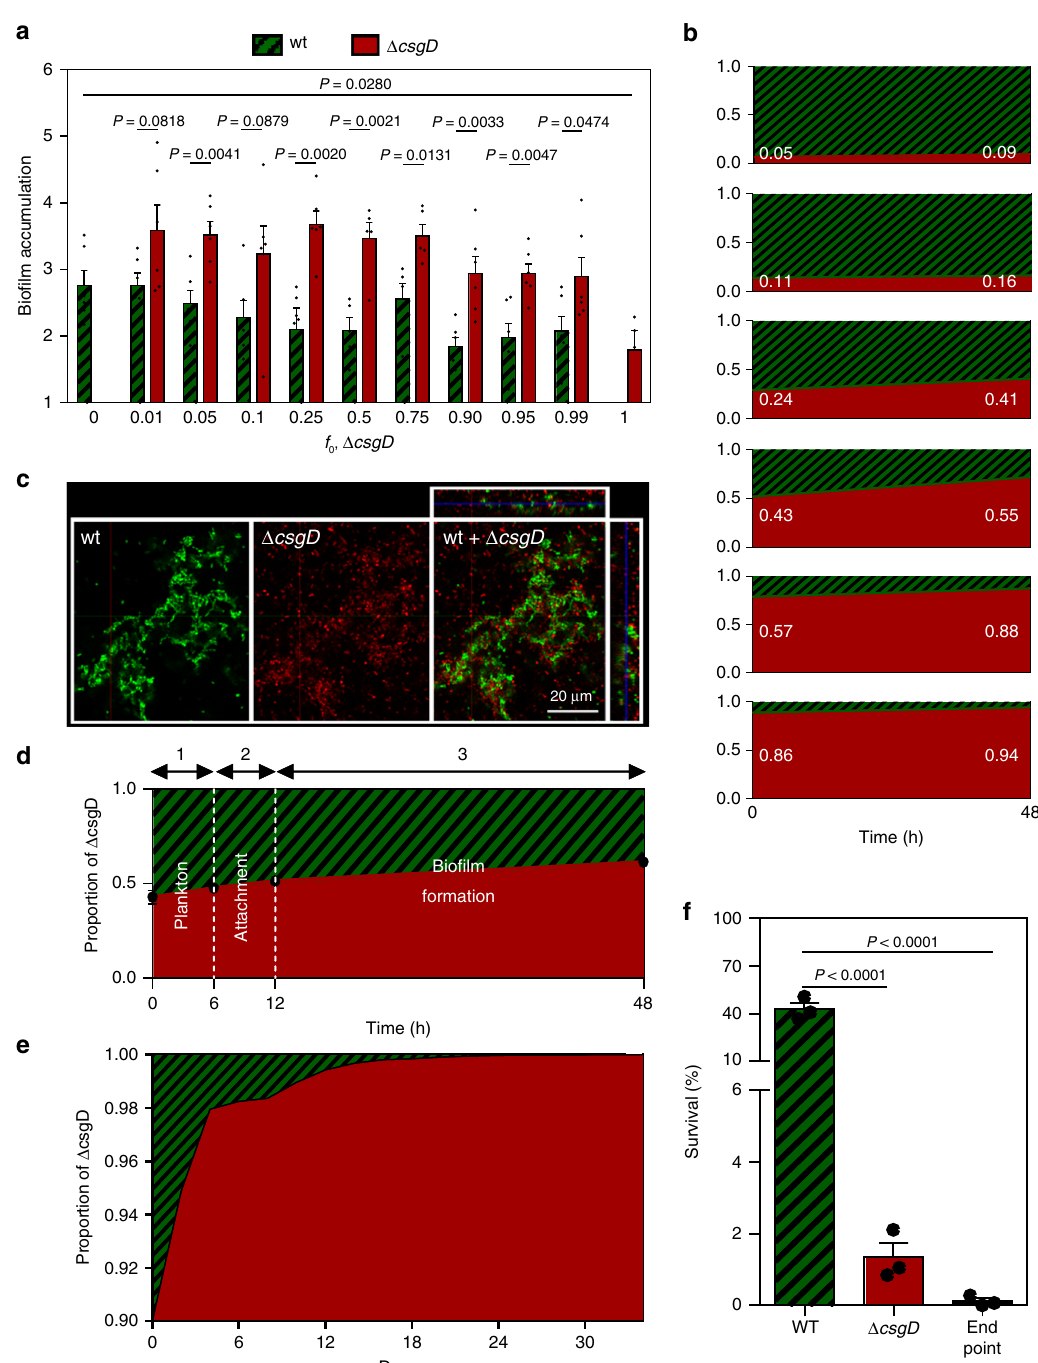
Fig. 2 Salmonella bio fi lm EPS is exploitable. Wild-type strain ATCC14028 (EPS producer) is indicated in (shaded) green; the isogenic Δ csgD mutant (EPS non-producer) is indicated in red. a Normalised bio fi lm accumulation of each strain during short-term competition, calculated as log inoculation fraction of Δ csgD . b Proportion of strains during short-term competition. c Confocal image of association between EPS producer and non- producer in the bio fi lm after 48 h ( f 0, Δ csgD = 0.9); left: split images, right: combined image. d Proportion of strains at different stages of growth during competition in petridishes, 1: plankton before attachment; 2: bio fi lm during attachment; 3: bio fi lm after attachment. To exclude interference from attaching cells when studying competition during growth in the bio fi lm, the planktonic phase above the bio fi lm was replaced by sterile nutrients at the 12 h time point. e Proportion of strains during long-term competition. f Survival of endpoint populations of long-term competition after treatment with H 2 O 2 (0.25%) in comparison with wild-type and Δ csgD mutant. For competition experiments a , b , d , e and microscopy c , wild type and Δ csgD mutant were fl uorescently labelled in green and red, respectively. A similar outcome a , b , and c was obtained when colors were reversed and competition was neutral when strains that only differ in the fl uorescent protein marker were competed against each other (Supplementary Fig. 2). Bars represent mean, dots represent measurements for biological replicates and error bars show s.e.m. ( n = 3 biologically independent samples, except in Fig. 2a, where n = 6). P values derived from two-tailed student ’ s t test a using Welch ’ s correction if s.d. are signi fi cantly ( P < 0.05) different and one-way ANOVA f , with Bonferroni multiple comparisons correction. Source data are provided as a Source Data fi